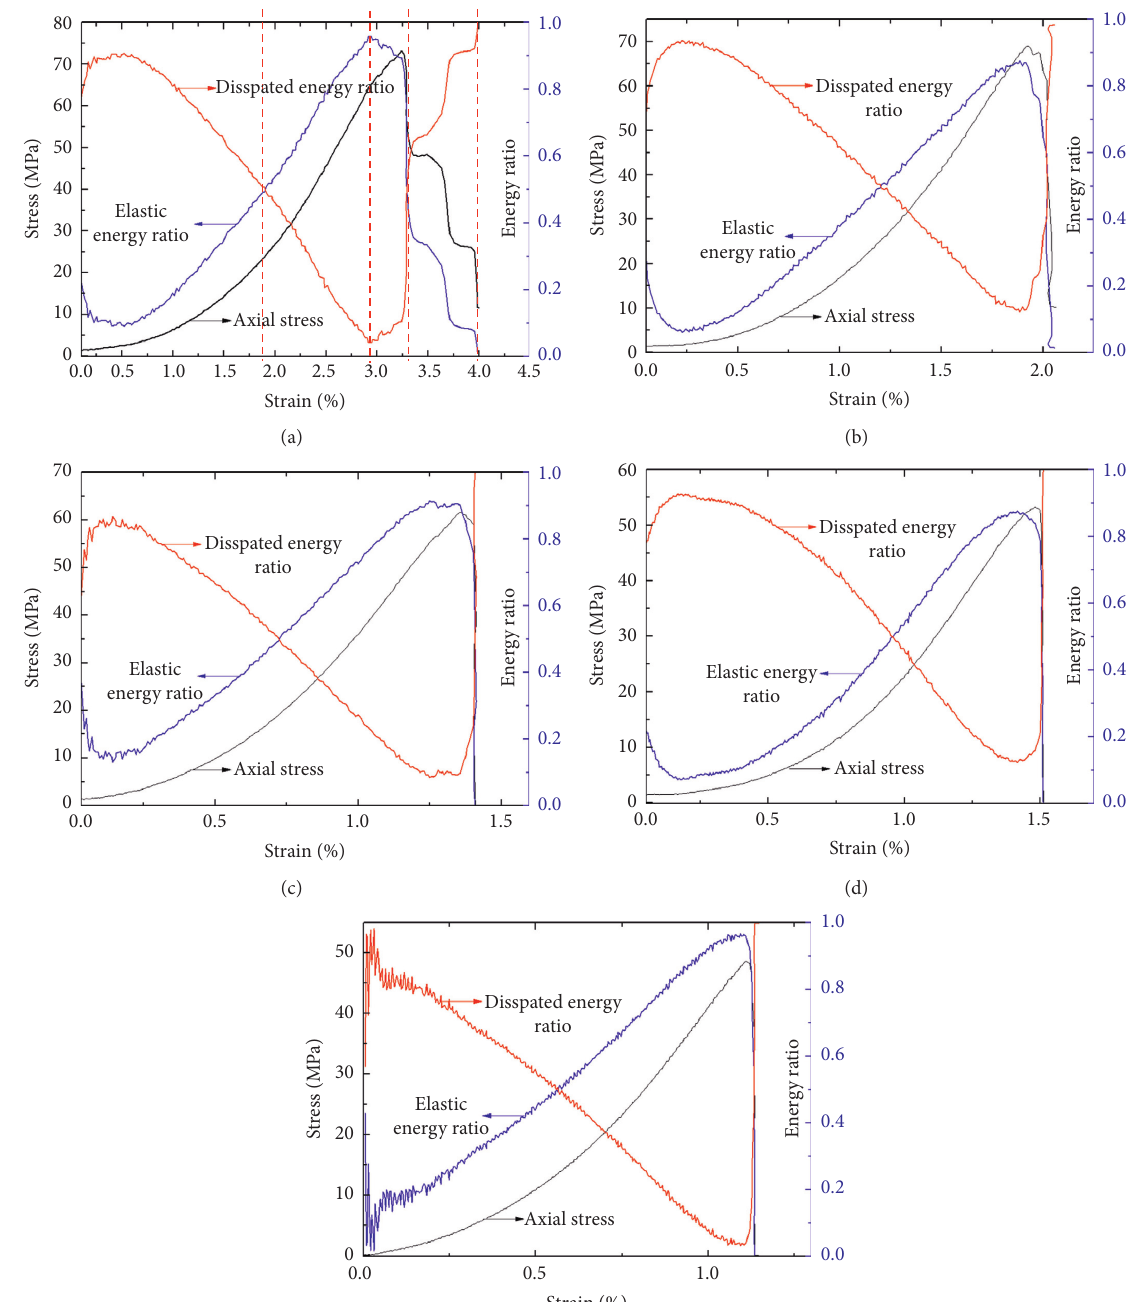
Figure 11: Energy ratio distribution curves and stress-strain curves of sandstone at different slenderness ratios. (a) D � 0.5. (b) D � 1.0, (c) D � 1.5, (d) D � 2.0, (e) D �